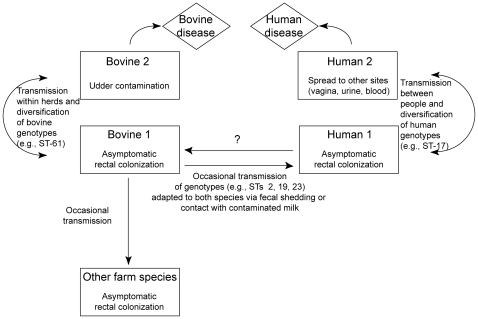
Hypothetical mode of group B Streptococcus (GBS) transmission between bovines and humans.It is possible that the diversification of GBS occurs independently in both humans and bovines, and only a subset of those strains can cause human and bovine disease. It is also possible that there is occasional transmission of GBS to other animal species (e.g, sheep, goats, etc.), particularly in a farm environment.